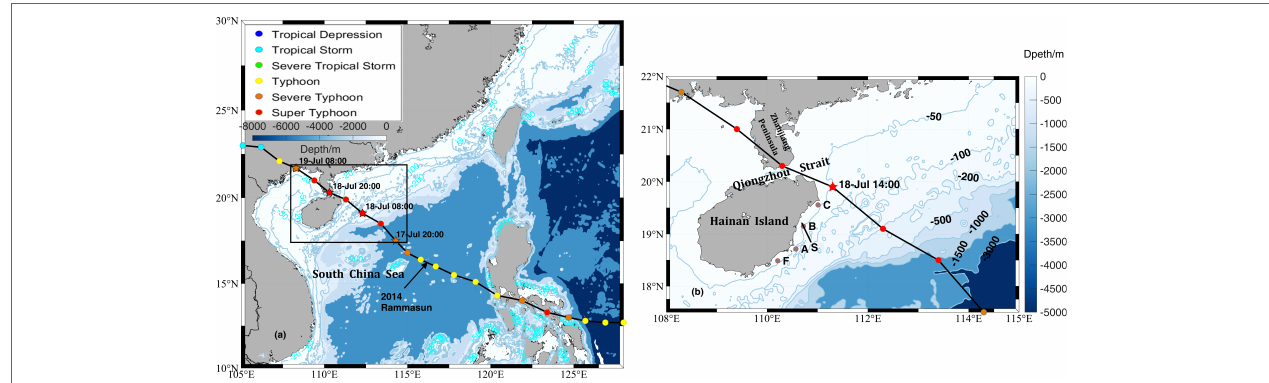
FIGURE 1 | (A) Bathymetry (m) of the northern South China Sea and the track of Typhoon Rammasun (2014). The typhoon track was recorded every 6 hours. The intensity of typhoon is represented by colored dots which are scaled by the maximum wind speed. Rammasun passed the northern Hainan Island as a super typhoon on July 18, 2014. (B) Bathymetry around Hainan Island. Stations A–C, F, and transect S in the upwelling region are used for